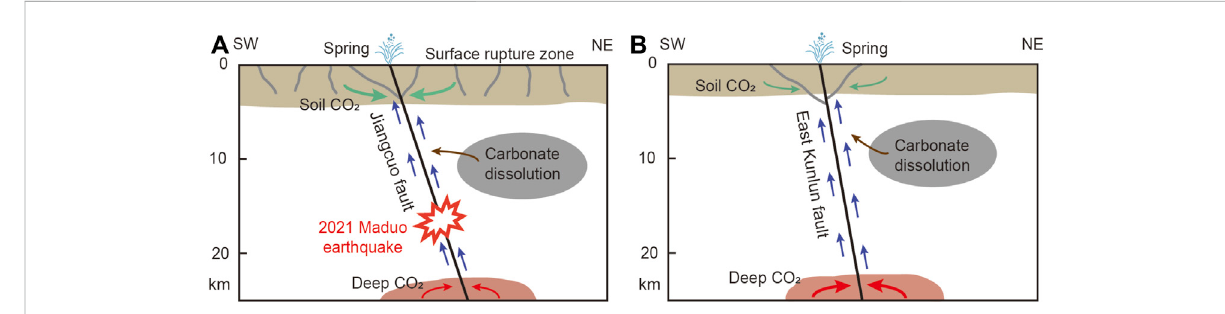
FIGURE 4 Schematic model showing carbon mobilization processes in the Maduo surface rupture zone (A) and the East Kunlun fault zone (B) . Note that inputsfromorganiccarboninsoilsarehigher(thickergreenarrows;Figure4A)inthespringwatersdischargingfromthesurfacerupturezoneformed by2021 Maduo earthquake, while thespring waters intheEastKunlun fault zonehave higher inputs fromdeep CO 2 (thicker redarrowsinFigure 4B).